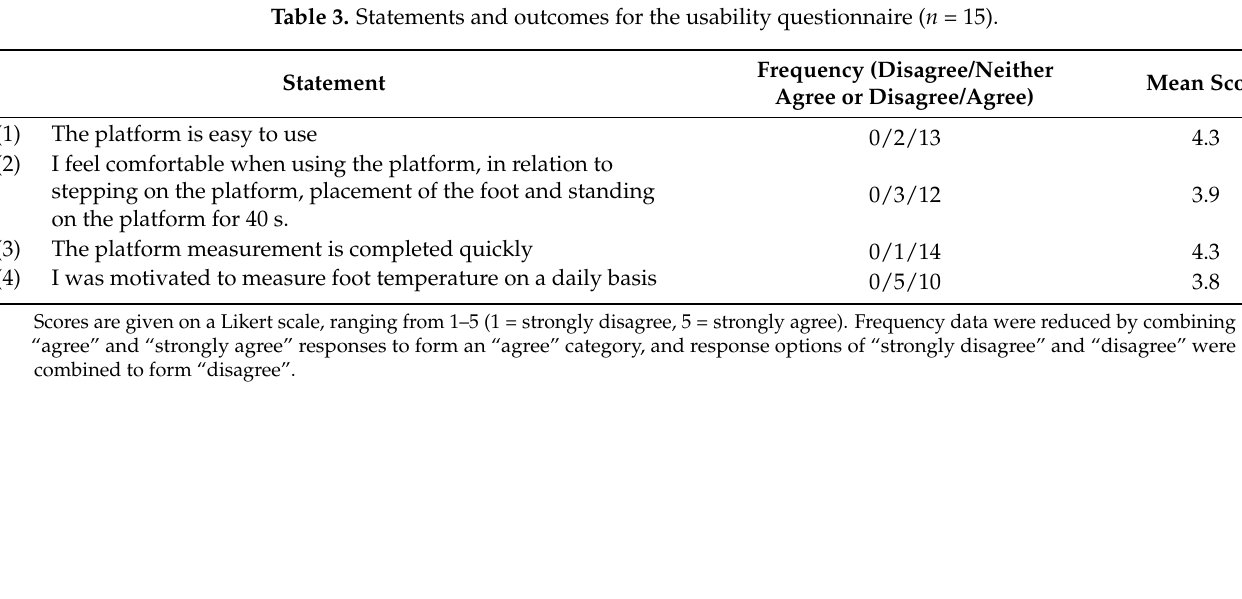
Table 3. Statements and outcomes for the usability questionnaire ( n =